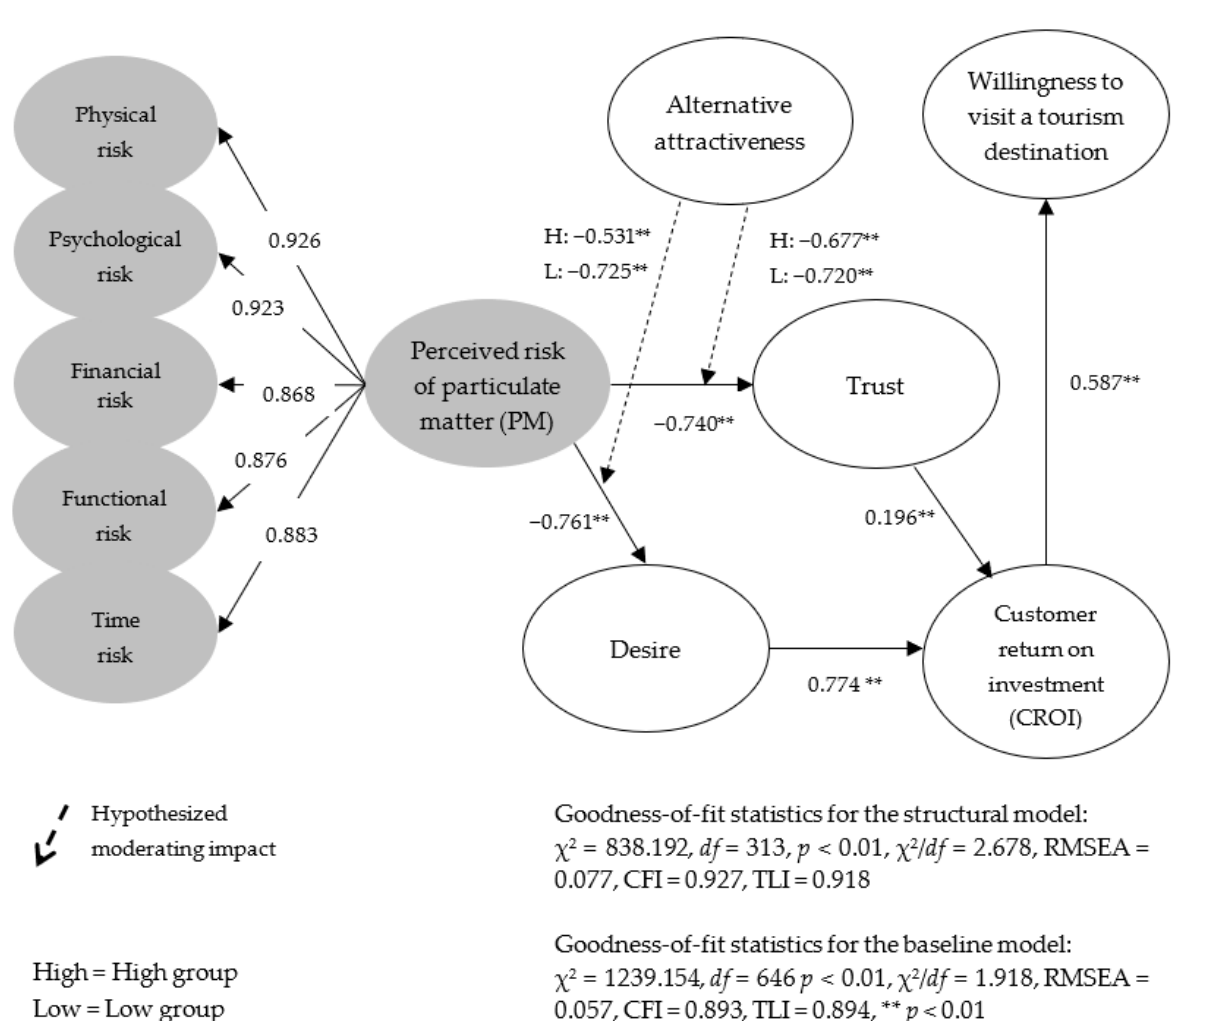
Figure 2. Structural model results and hypotheses testing.